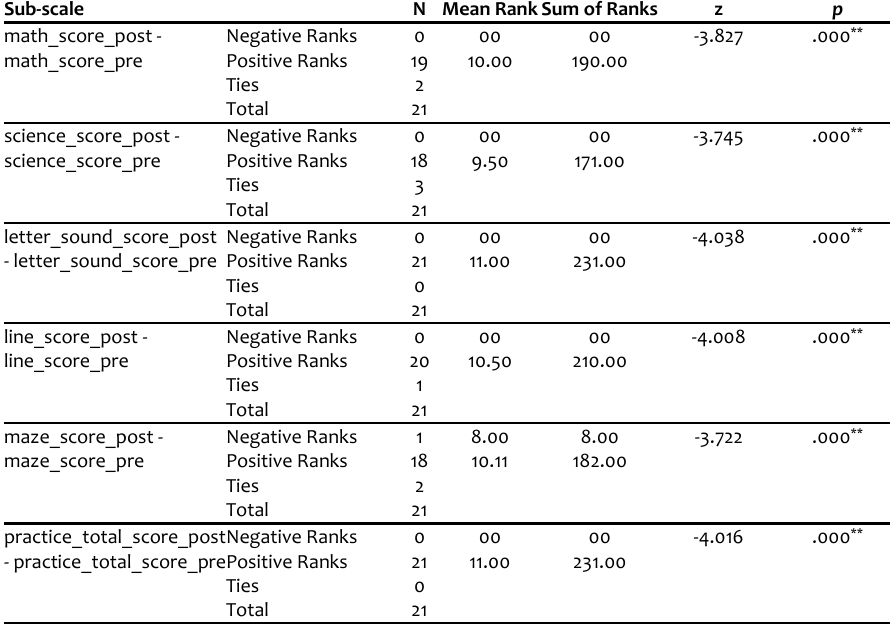
Table 3. Pre-test and post test results of the practice scores in experimental group Sub-scale N Mean Rank Sum of Ranks